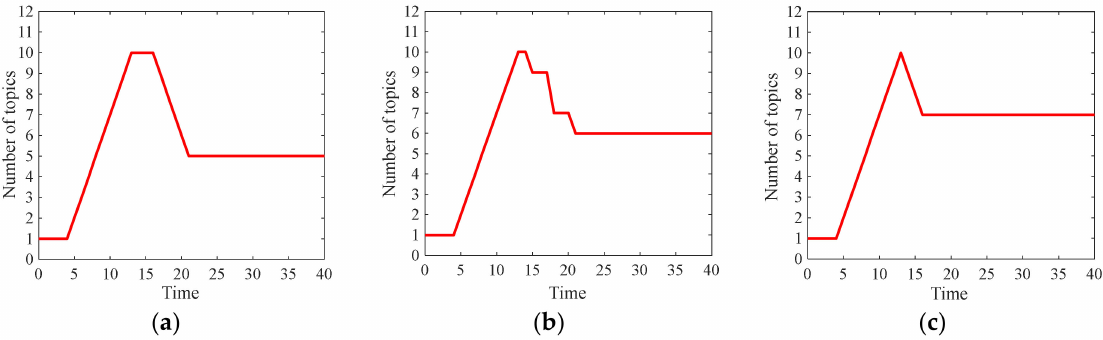
Figure 30. The change of number of topics under different network topologies. ( a ) WS small world network. ( b ) BA network. ( c ) Fully connected